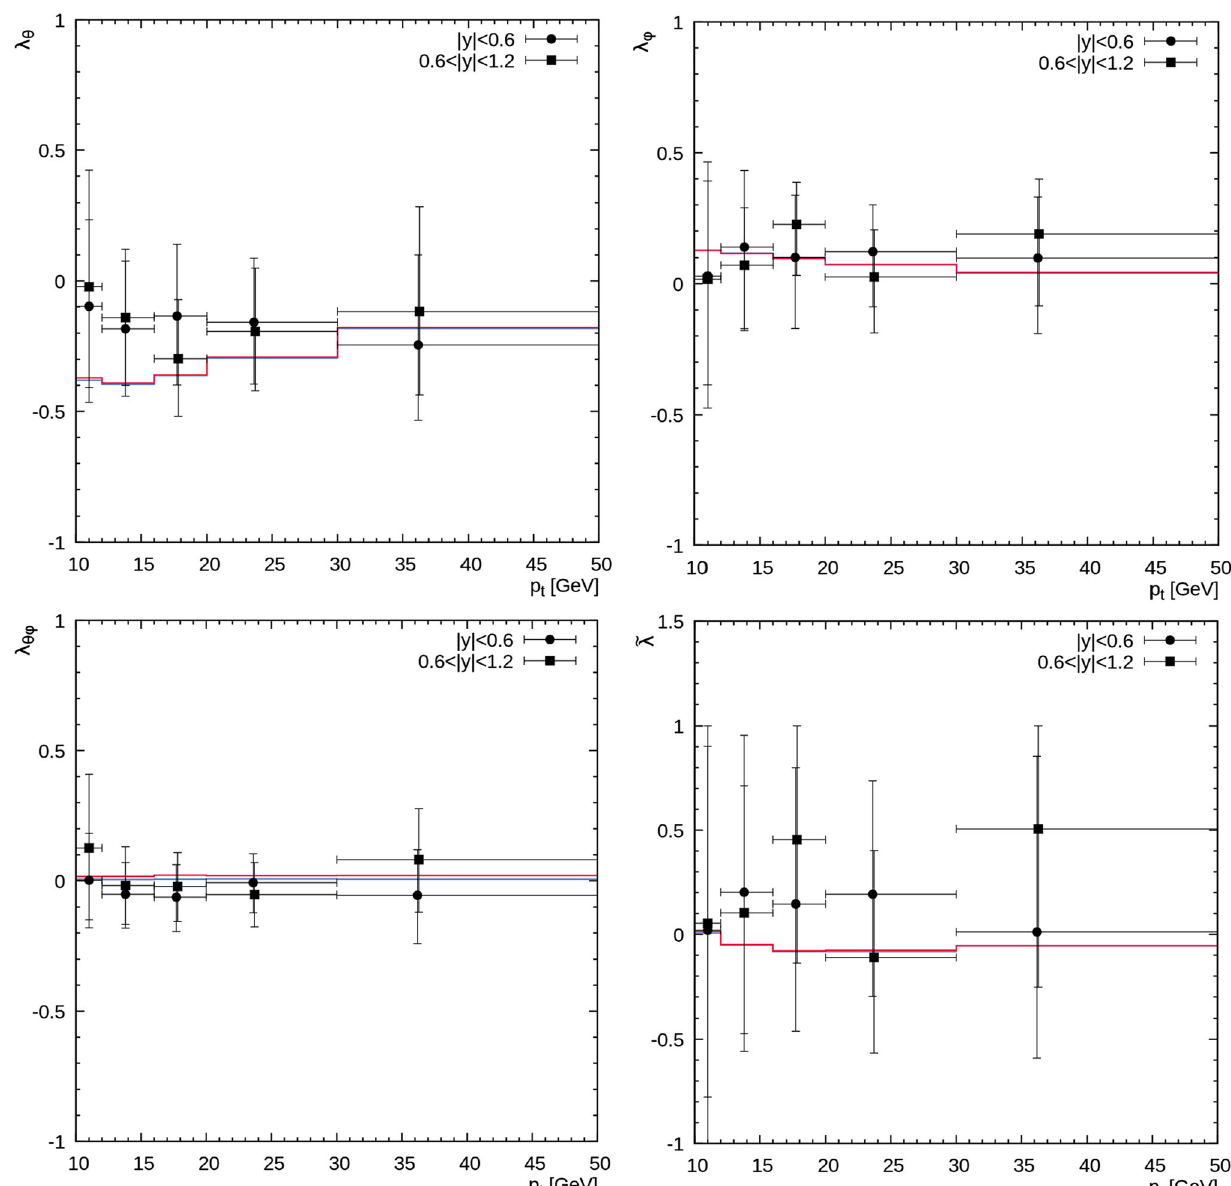
Fig. 7 Thepolarizationparameters λ θ , λ φ , λ θφ and ˜ λ of ϒ( 3 S ) mesons calculated in the CS frame as function of its transverse momentum at √ s = 7TeV.TheA0gluondensityisused.Theblueandredhistograms